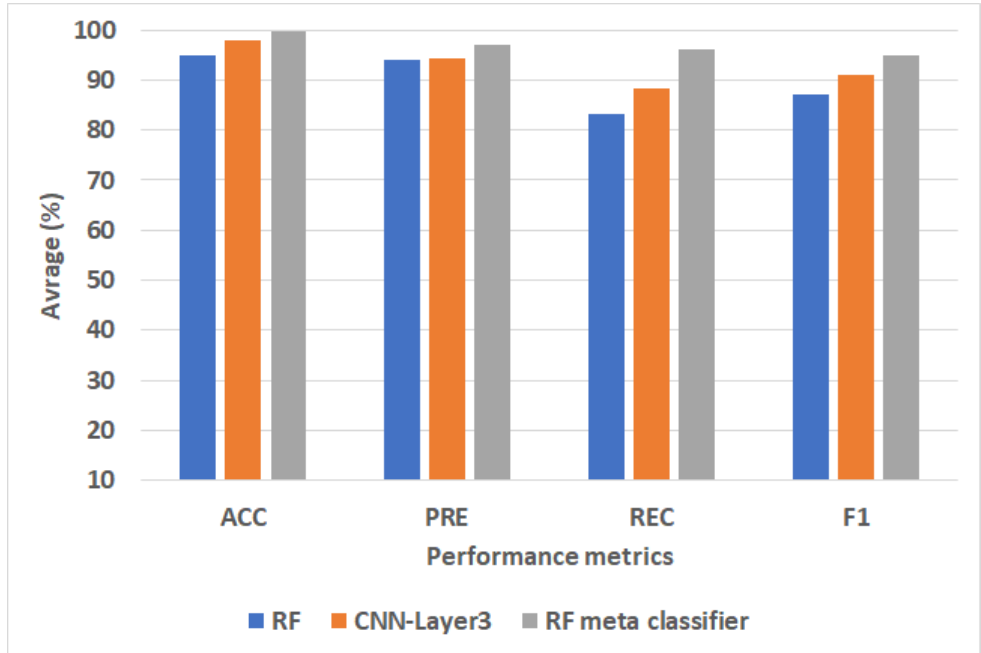
Figure 4. The best ML, CNN, and proposed models for the PTB